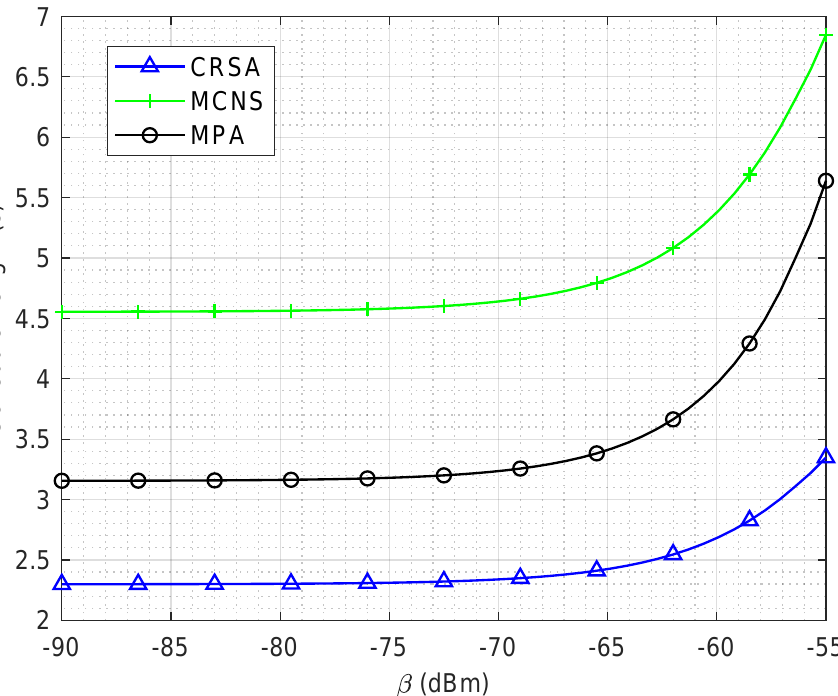
Figure 5. Schedule length of the algorithms for different interference levels in a network of 10 cells and 50